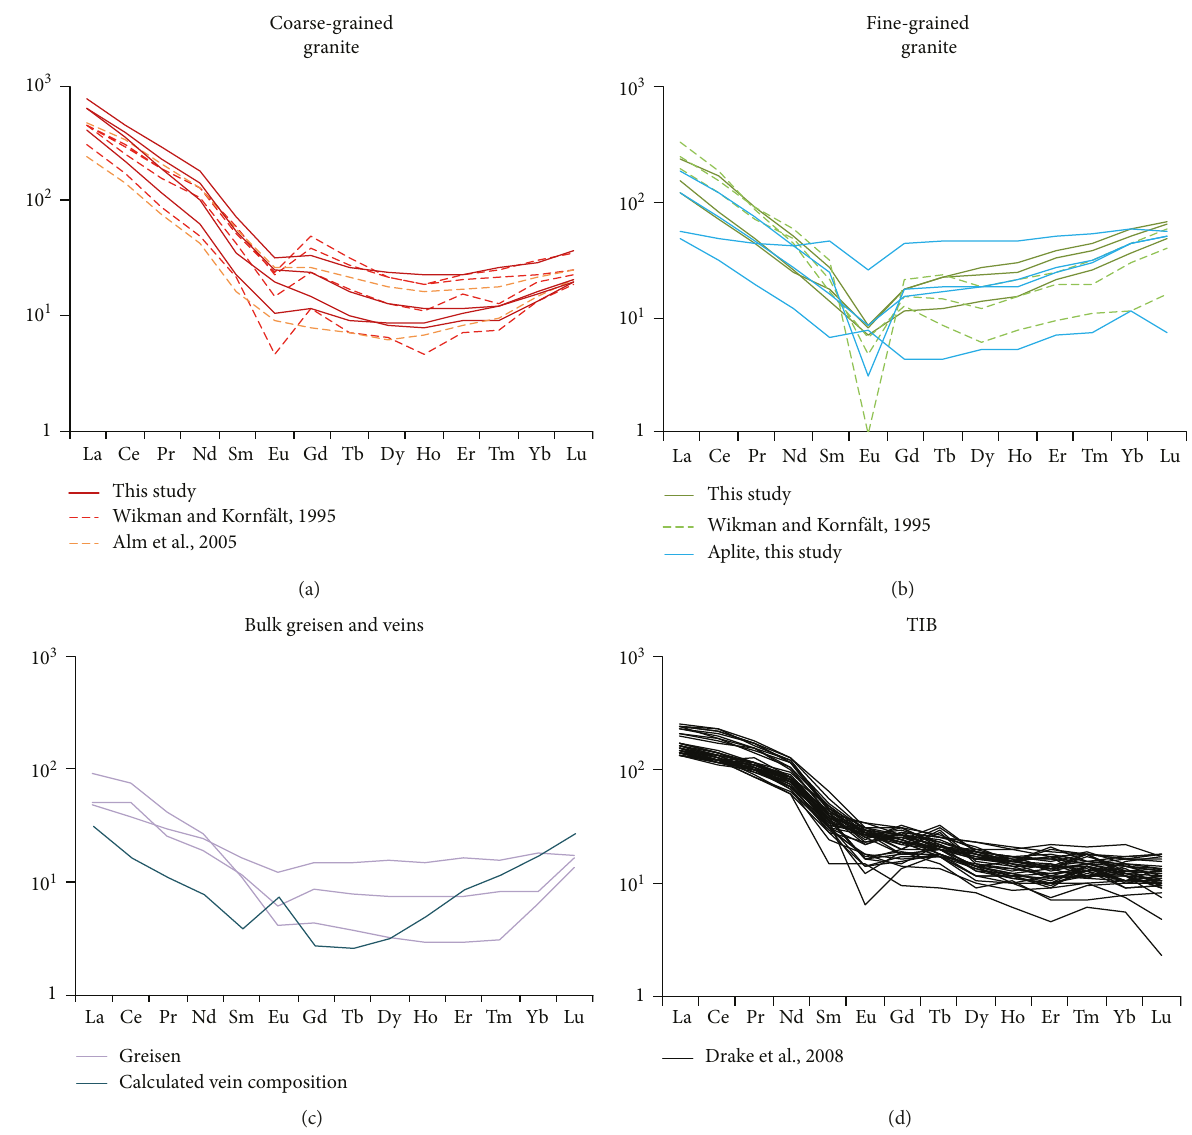
Figure 3: Chondrite-normalized [40] REE whole-rock concentrations of (a and b) the Götemar granite ( n = 16 ), (c) greisen ( n = 3 ) and for the calculated bulk vein ( n = 28 , see text), and (d) rocks of the Transscandinavian Igneous Belt (TIB; n = 44 ) derived from Drake et al.